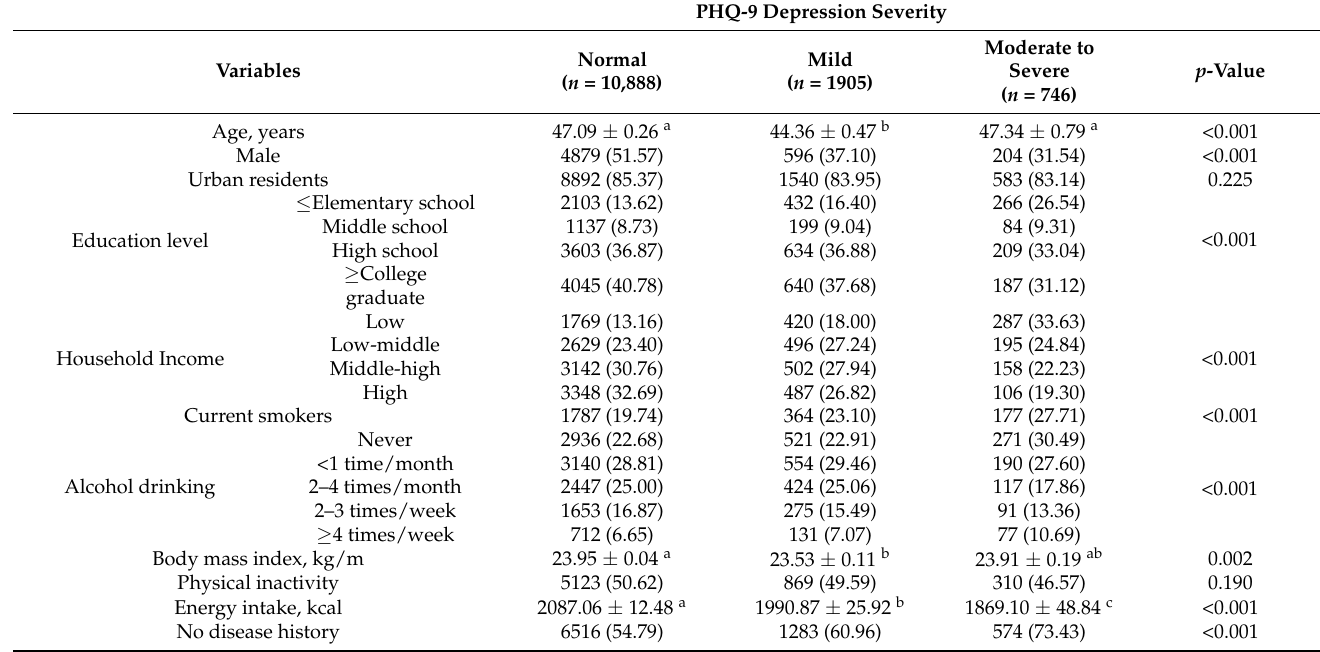
Table 1. Socio-Demographic factors of subjects according to depression severity.